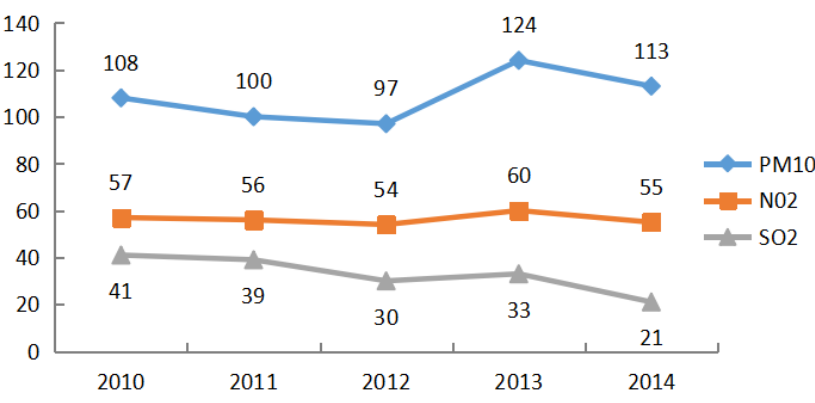
Figure 3. Variations of main air pollutant concentrations in Wuhan from 2010–2014.